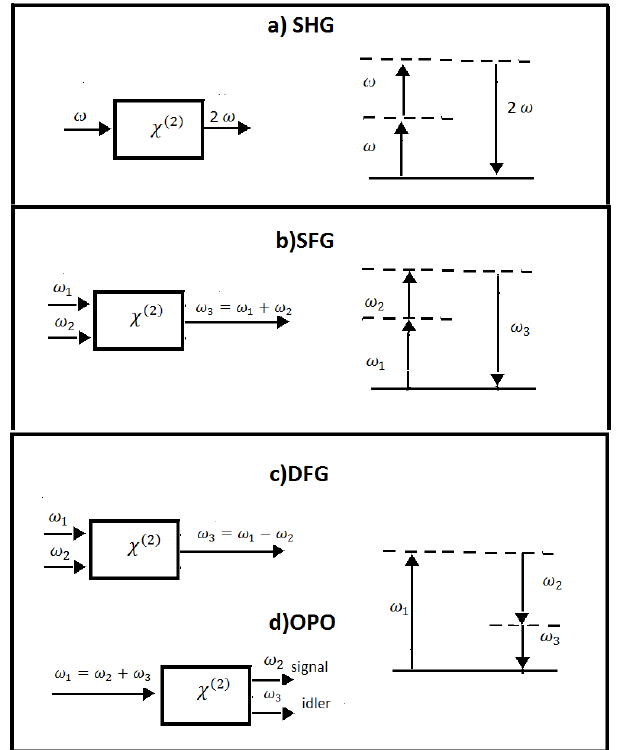
Figure 1. ( a ) Second-harmonic generation, ( b ) sum-frequency generation, ( c ) difference-frequency generation, and ( d ) optical parametric oscillations. In the left column, the geometry of interactions is shown, while in the right column, the energy level diagrams describing the interactions are represented.